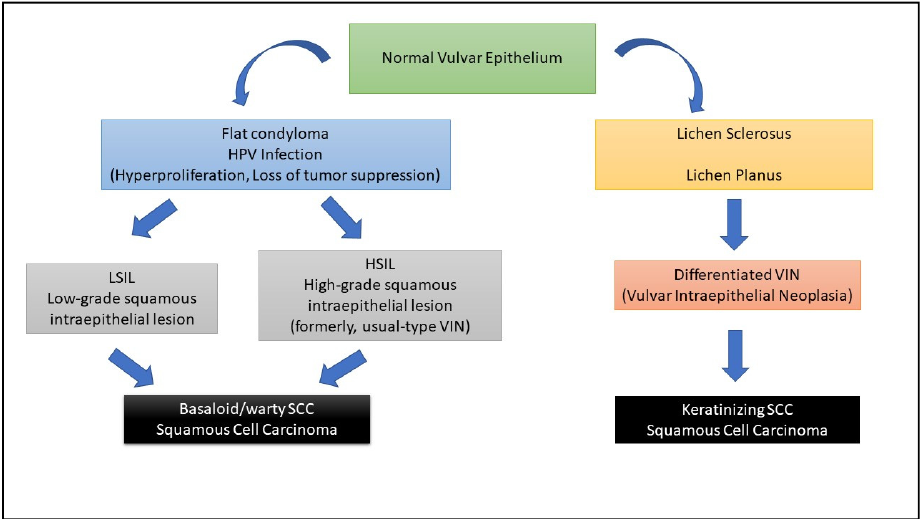
Figure 1. Schematic representation of the pathophysiology of the vulvar cancer.